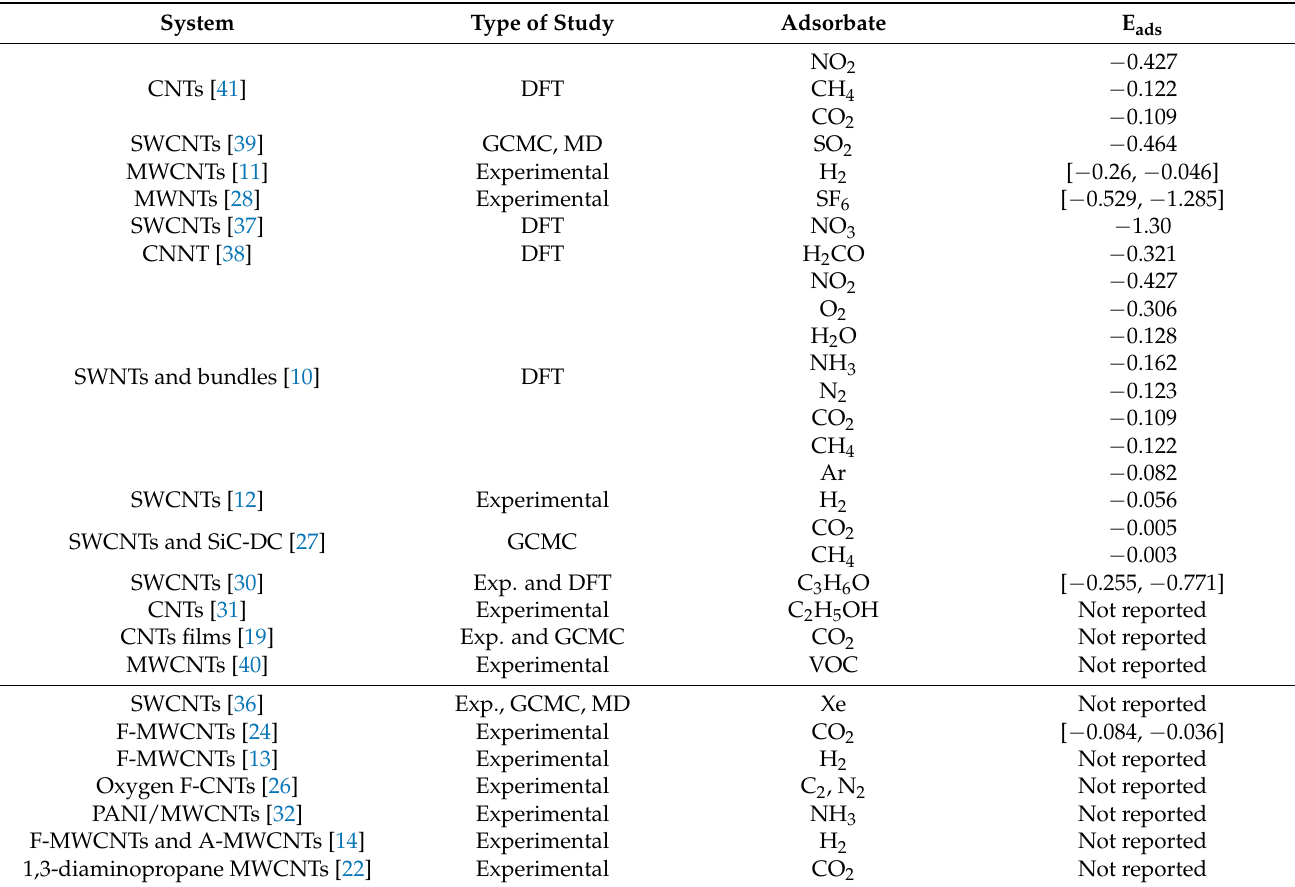
Table 1. Summary of adsorption energies E ads (in eV) for different non-metallic doped nanotubes systems and adsorbates. The type of study is also